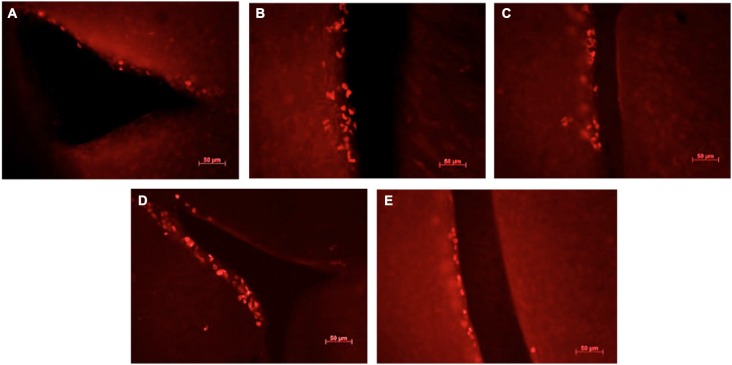
Ki67-positive cells in the sub-ventricular zone of the lateral ventricles in female mice exposed to different scents. Photomicrographs of representative responses when females were exposed to a water control (A), male CD-1 urine (B), male BALB/c urine (C), male BALB/c urine mixed with 1 μg/μl r-darcin (D) or female CD-1 urine (E). Mean cell counts for each treatment are shown in Figure 4A.